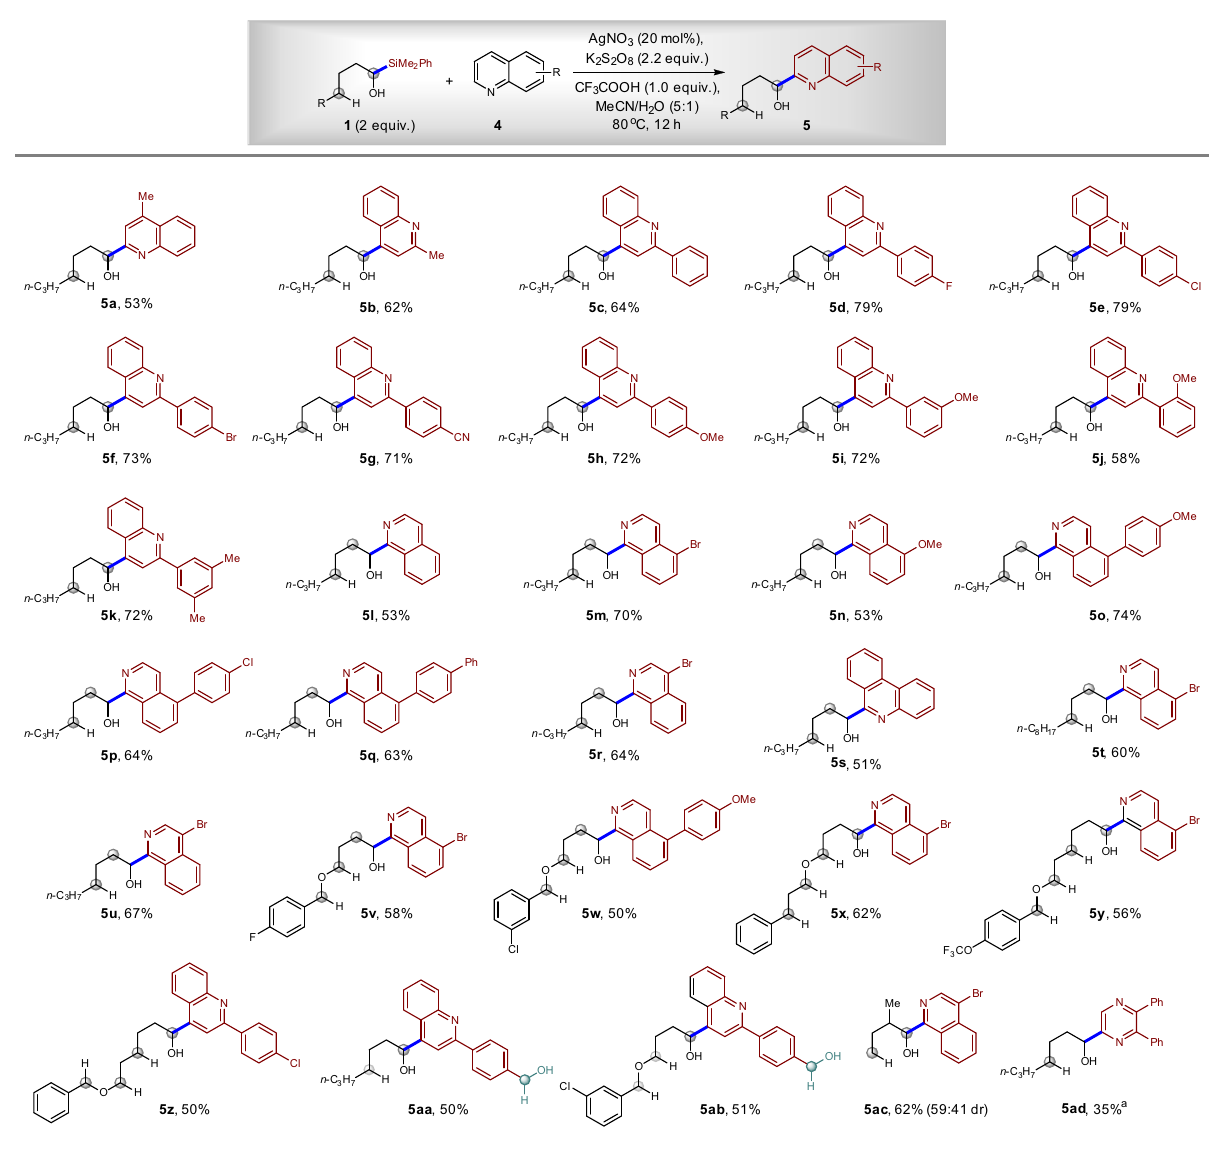
Fig. 9 Scope of Minisci reaction for the synthesis of α -heteroaryl alcohols. The reaction could tolerate various C – H bonds and benzyl alcohols that are reactive in oxidative C – H functionalization reactions. a DMSO/H 2 O (v/v = 5:3) was used as the aqueous solution (10 mL), extracted with ethyl acetate (3 × 10 mL), and the organic phase was combined and washed with brine, dried over anhydrous Na 2 SO 4 , and concentrated under reduced pressure. The crude product was puri fi ed with column chromatography on silica gel (200 – 300 mesh) with PE/EA (10/1, v/v) as eluent to afford 27.0 mg of the title compound as a faint yellow oil (53% yield). Data availability The authors declare that all other data supporting the fi ndings of this study are available within the article and Supplementary information fi les, and also are available from the corresponding author on reasonable request.